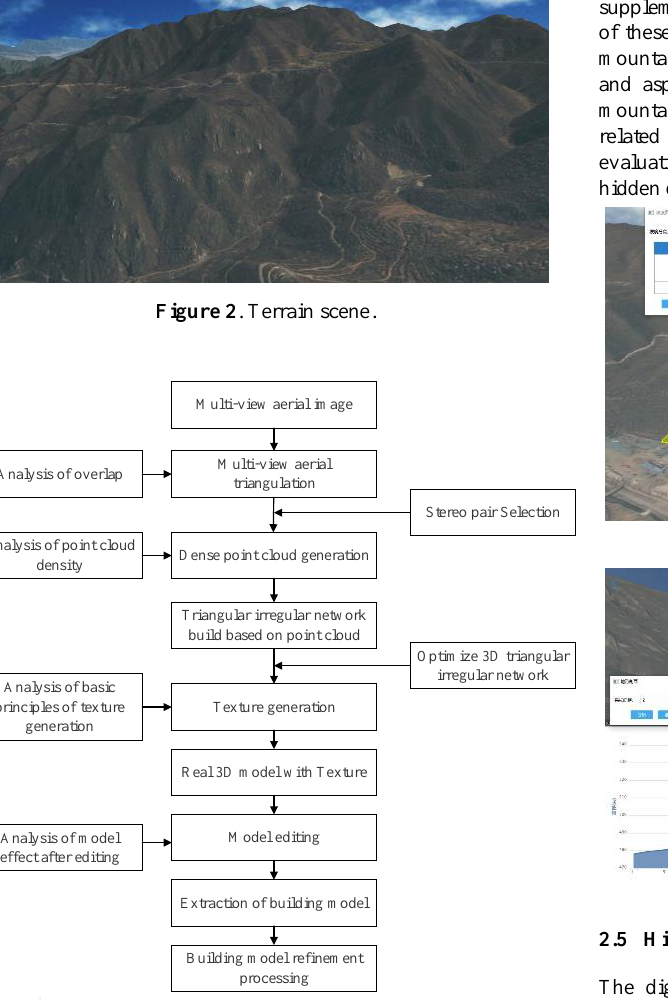
Figure 3 . The process of Real 3D model construction.